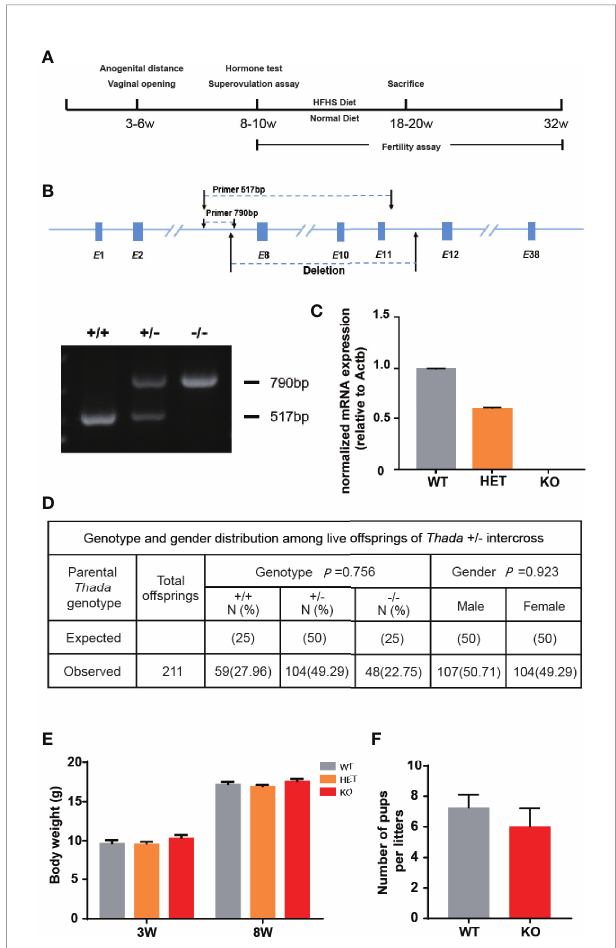
FIGURE 1 | Thada knockout mice have normal fertility. (A) The fl owchart of experimental design. (B, C) . Generation and denti fi cation of Thada knockout mice. Ef fi ciency of knockdown in ovary was determined by qPCR. (D) The genotype distribution and the male/female ratio of offsprings were obtained by mating Thada +/- (n = 211). (E) . KO and WT had similar body weights (n = 15- 24). (F) WT and KO female mice had the similar litter size (n =